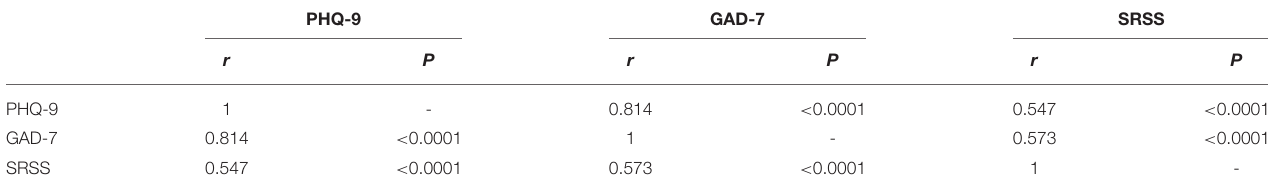
TABLE 4 | Correlations between PHQ-9, GAD-7, and SRSS.